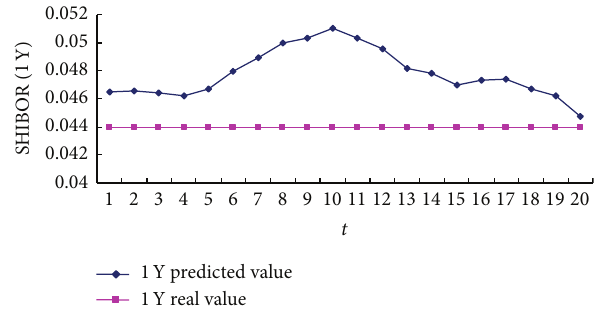
Figure 4: One-month SHIBOR forecast figure.